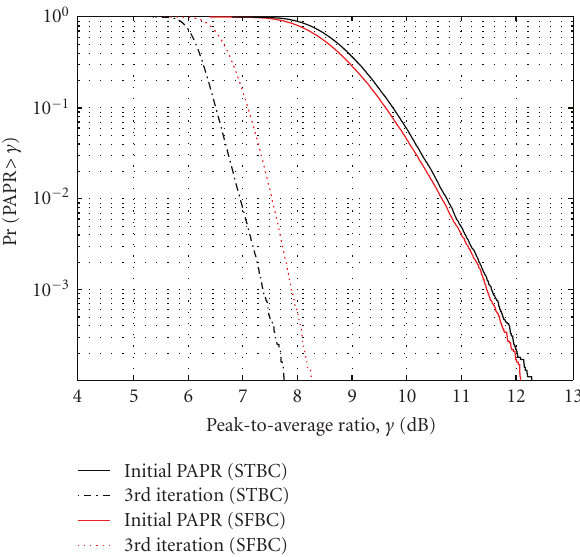
Figure 1: CCDF Results with 2-Tx antenna STBC/SFBC using 256 subcarriers employing QPSK.